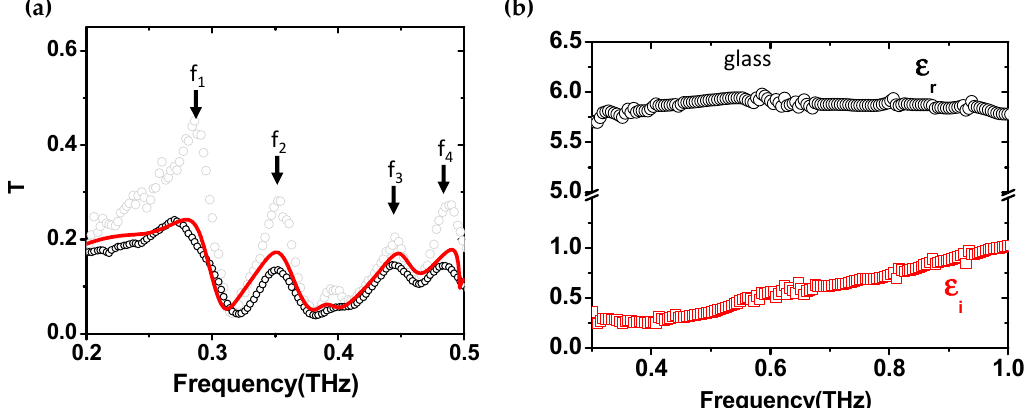
Figure 2. ( a ) Grey and black circles represent the experimental Terahertz (THz) signal transmission of the bare and capped (without analyte) metagrid respectively. The frequencies f 1–4 indicate the most sensitive transmission resonances. The red curve is the full wave simulation of the CMG transmission. ( b ) Values of the real (black circles) and imaginary (red squares) part of the dielectric function for the cover glass slab vs. frequency up to 1 THz.